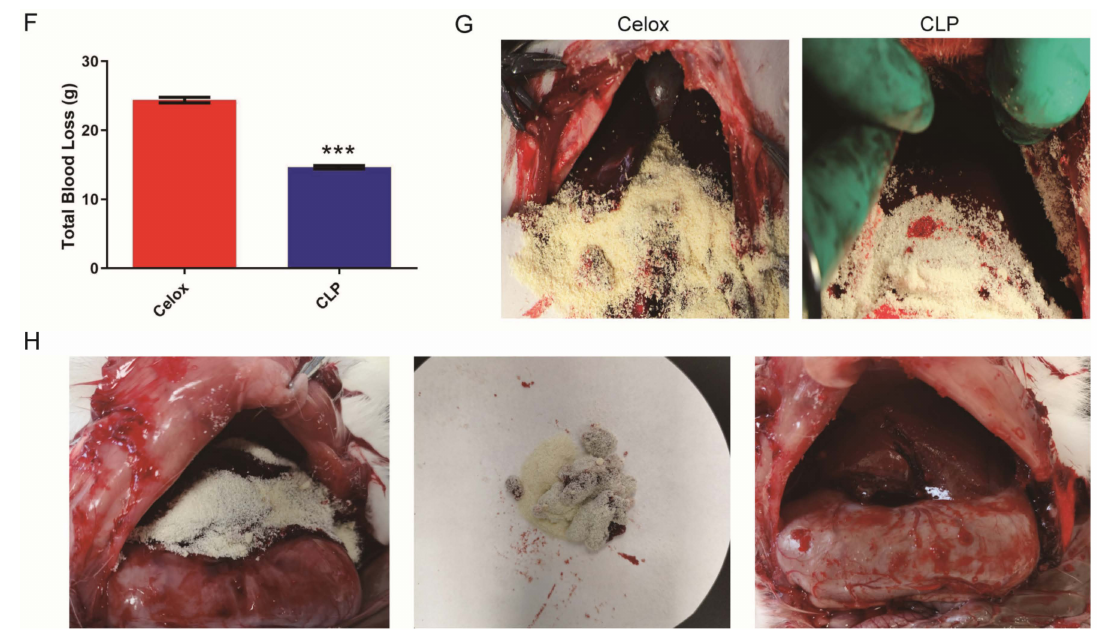
Figure 5. In vivo evaluation of material effectiveness on liver hemostasis. ( A ) Visual image of the removed liver (rat: 3 ± 0.5 cm; rabbit: 5 ± 0.5 cm; dog: 8 ± 0.5 cm). ( B ) Blood loss statistics, and ( C ) the hemostasis process of rat liver hemorrhage treated with these hemostatic particles. ( D ) Blood loss statistics and ( E ) hemostasis process of rabbit liver hemorrhage treated with these hemostatic particles. ( F ) Blood loss statistics and ( G ) hemostasis process of beagle liver hemorrhage treated with these hemostatic particles ( n = 3). ( H ) Hemostasis process of rabbit liver hemorrhage treated with CLP., the stripped CLP and liver wound after normal saline washing, from left to right. Values represent means ± SEM. The differences between each group were performed using a two-tailed unpaired t -test. The ‘NS’ indicated no significant difference, *** p <